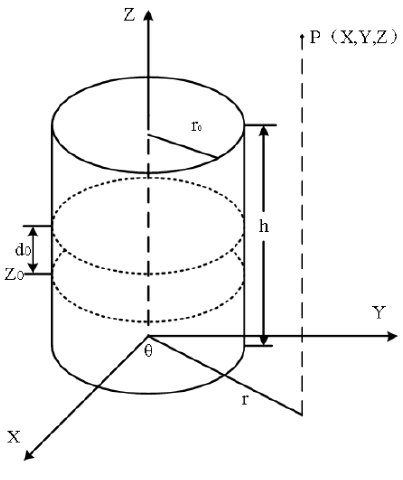
Figure 4. Cylindrical permanent magnet.